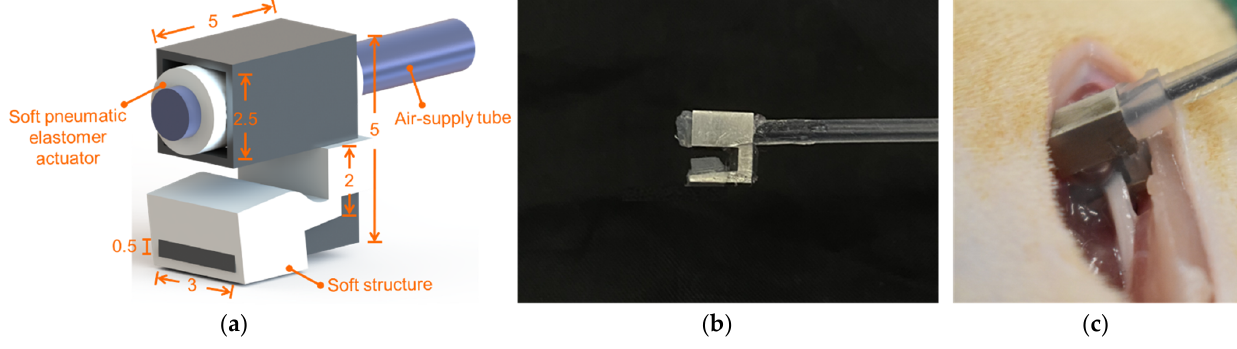
Figure 1. The soft hybrid surgical gripper used in this study: ( a ) The dimension of the soft hybrid surgical gripper in millimeters; ( b ) The soft hybrid surgical gripper before gripping; ( c ) Gripping the rat sciatic nerve using the soft hybrid surgical gripper.